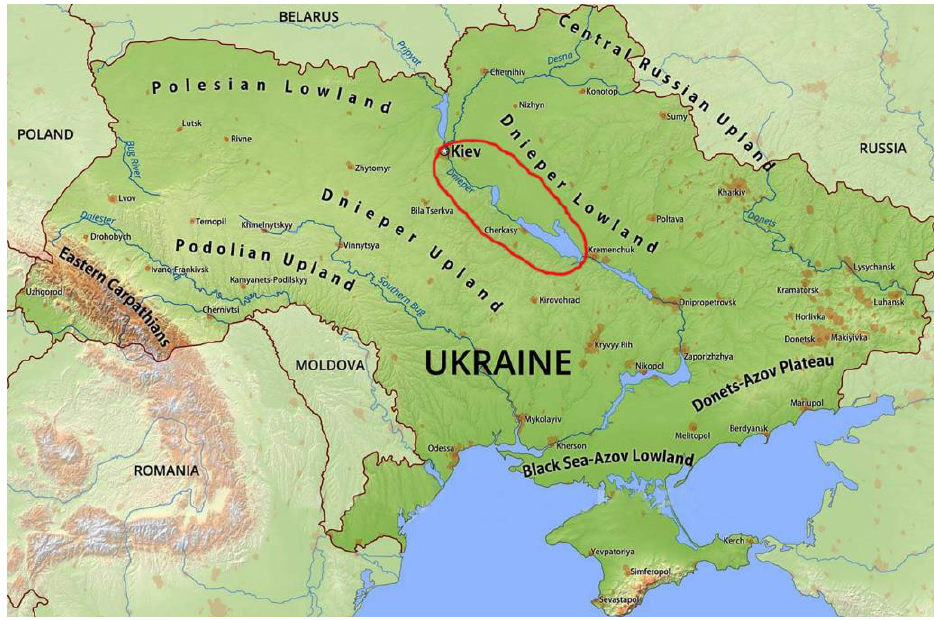
Fig. 1. Map scheme of the study